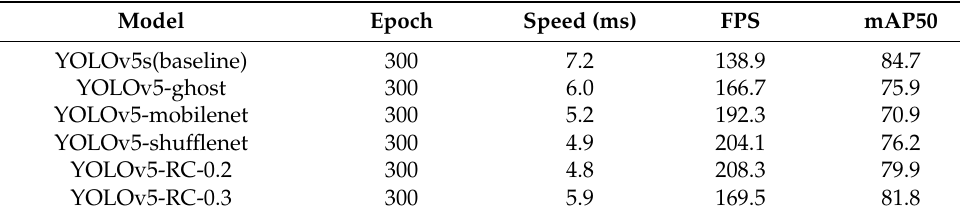
Table 5. FPS and mAP50 in YOLOv5 lightweight work under different methods.